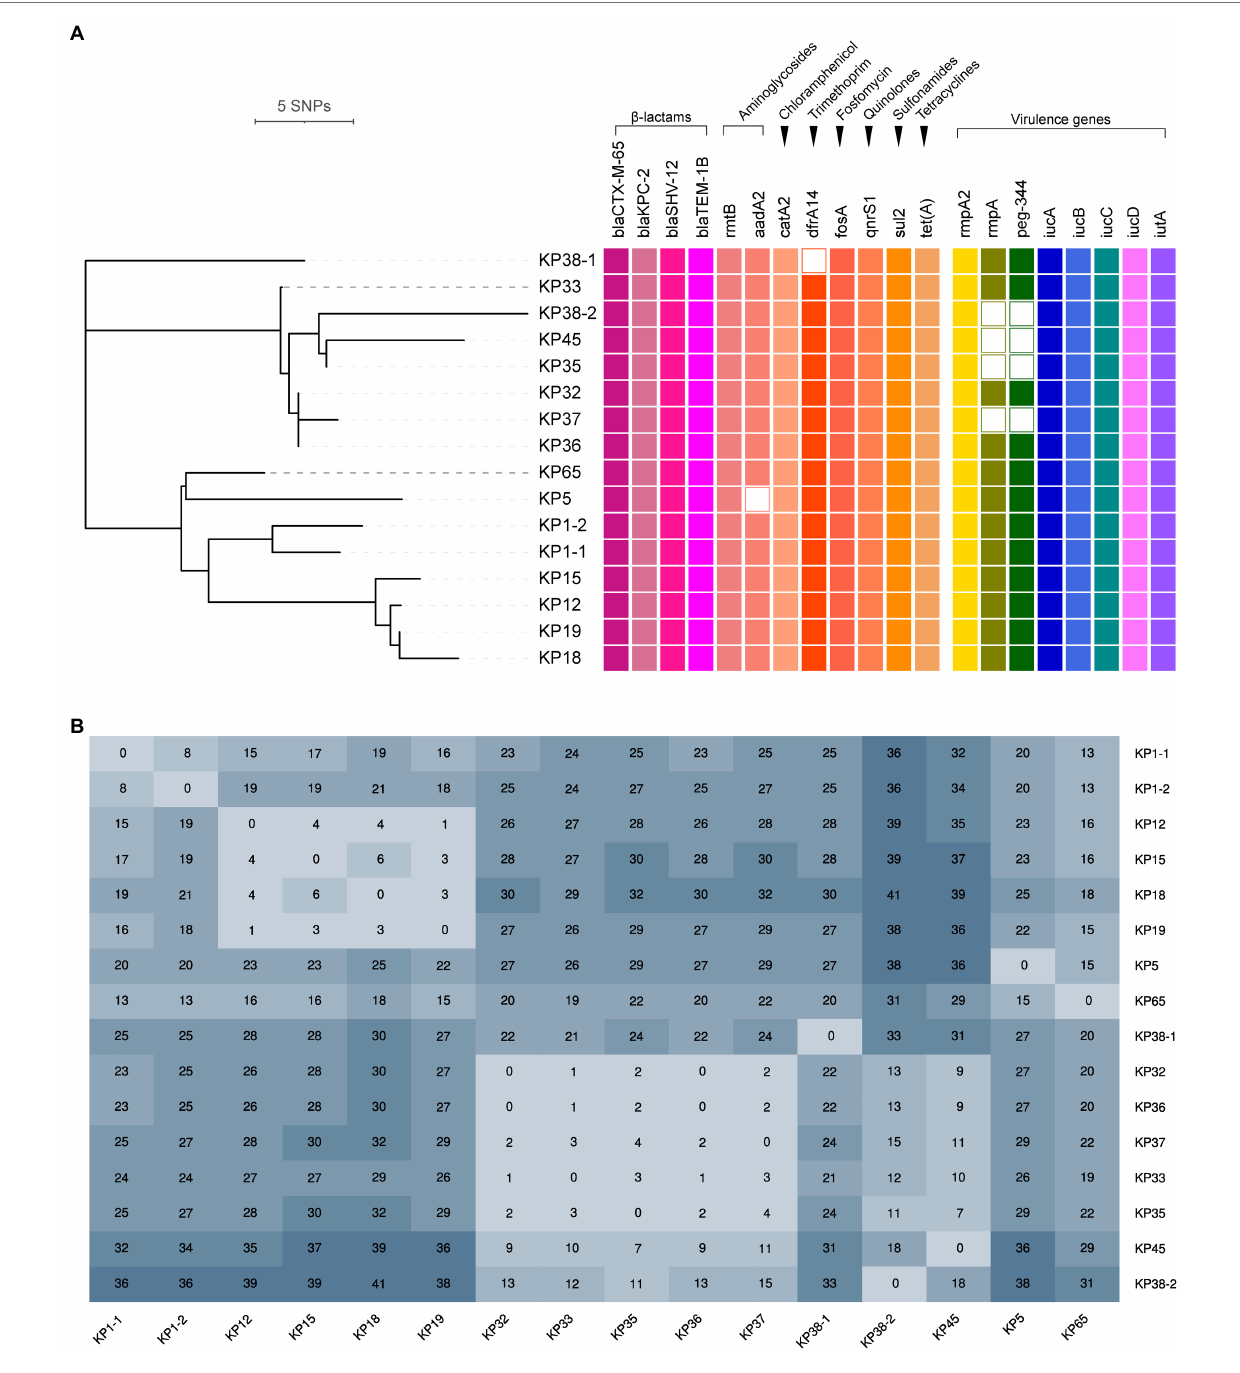
FIGURE 2 | Phylogenetic analysis of 16 K. pneumoniae carbapenemase (KPC)-2-producing ST11-KL64 CRKP isolates. (A) Recombination-filtered core genome phylogeny and the distribution of antimicrobial resistance genes and virulence genes in the CRKP isolates. The cell in different colors represents the presence of the gene, while the blank cell represents the absence of the gene. (B) The single nucleotide polymorphisms (SNPs) numbers between each